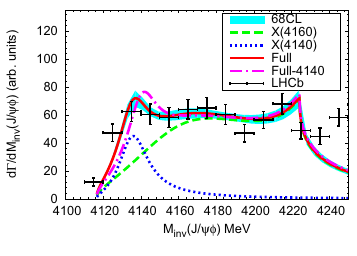
Figure 4. The J /ψφ mass distribution of the B − → K − J /ψφ decay. The band comes considering the errors in A , B and Γ 0 from the fit, and represents the 68%